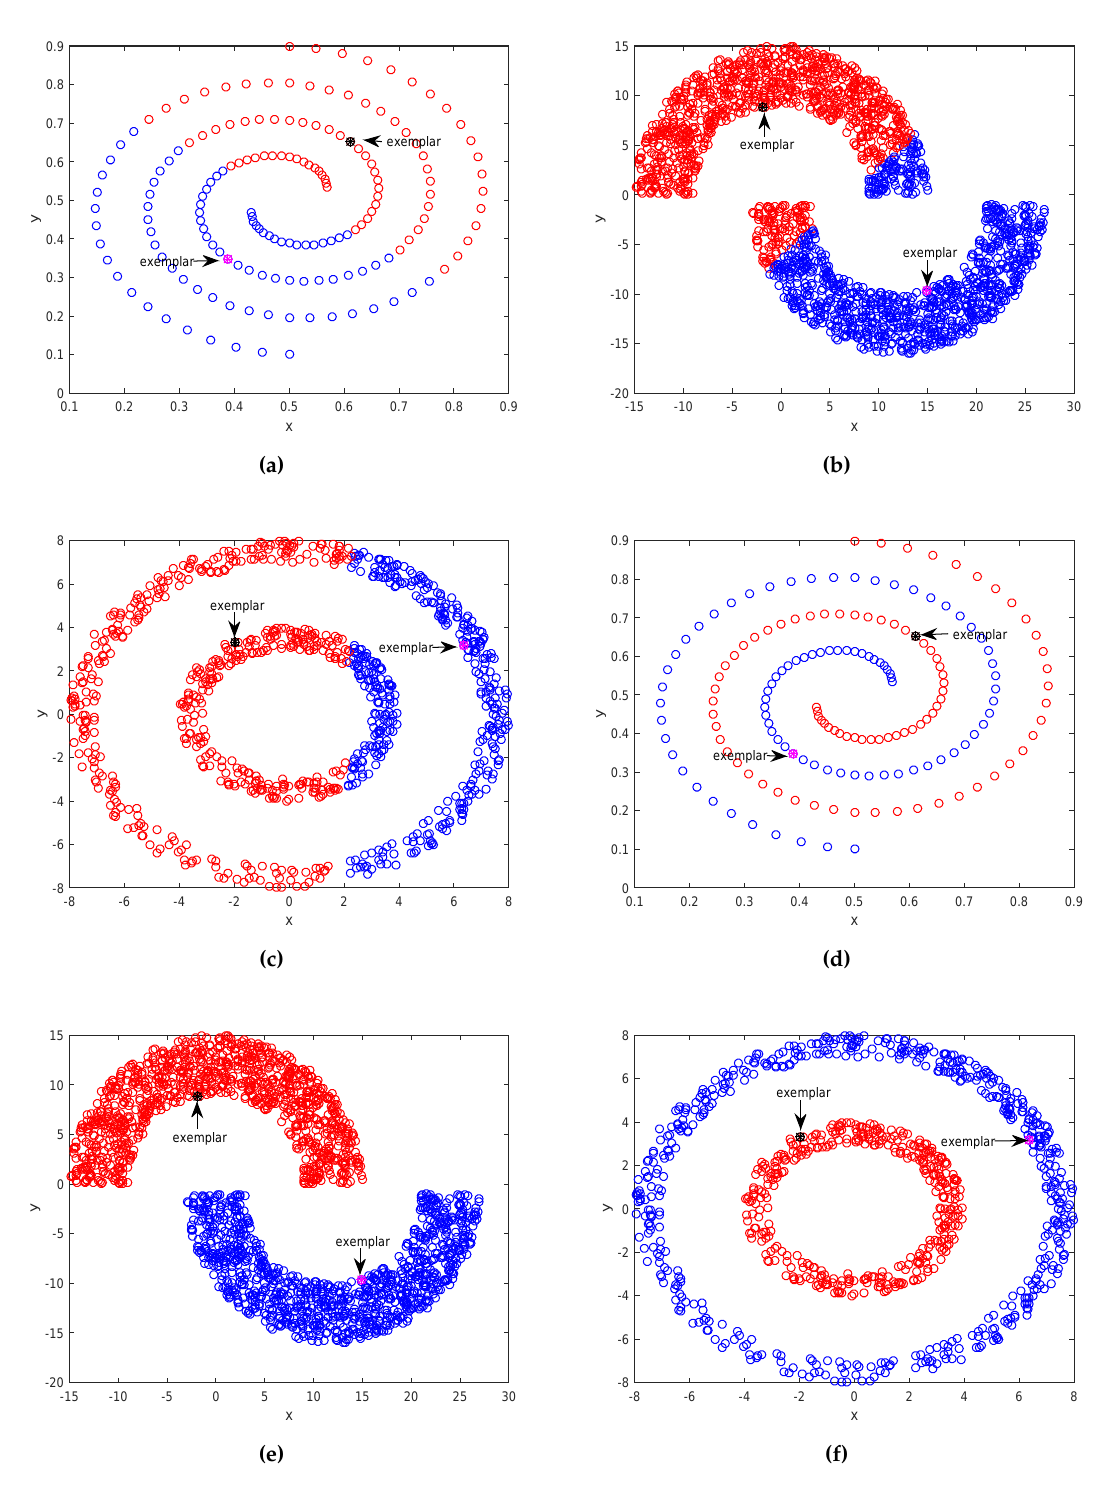
Figure 2. Discovered clusters of affinity propagation clustering (APC) and affinity propagation clustering based on path-based similarity (APC-PS) on three artificial datasets. Upper figures ( a – c ) show the results of APC, and lower figures ( d – f ) show the results of